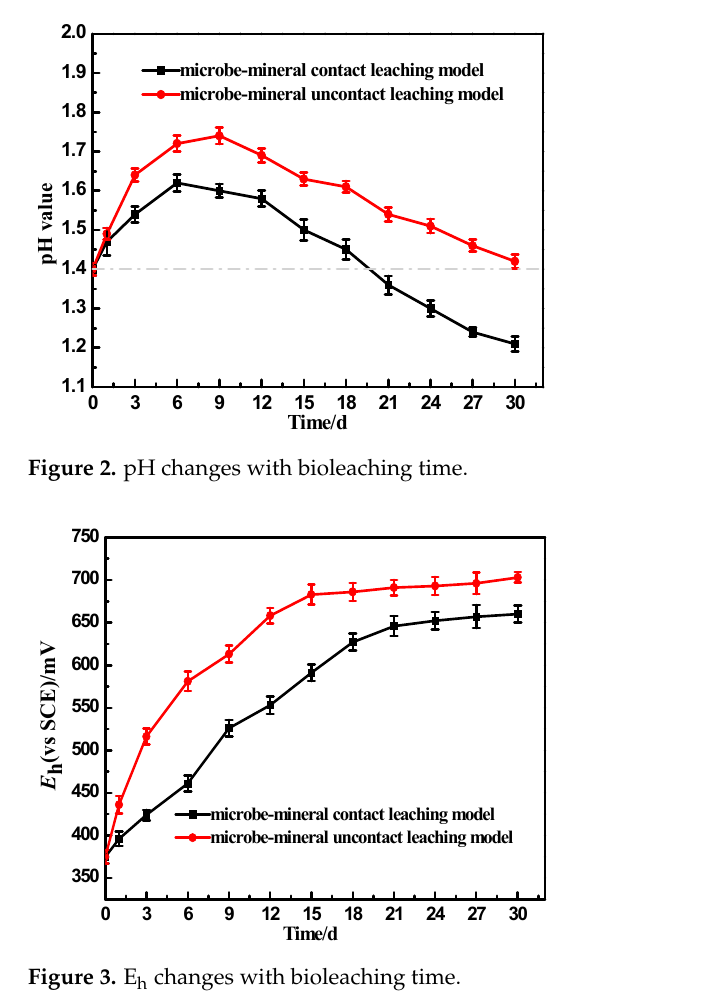
Figure 3. E h changes with bioleaching time .